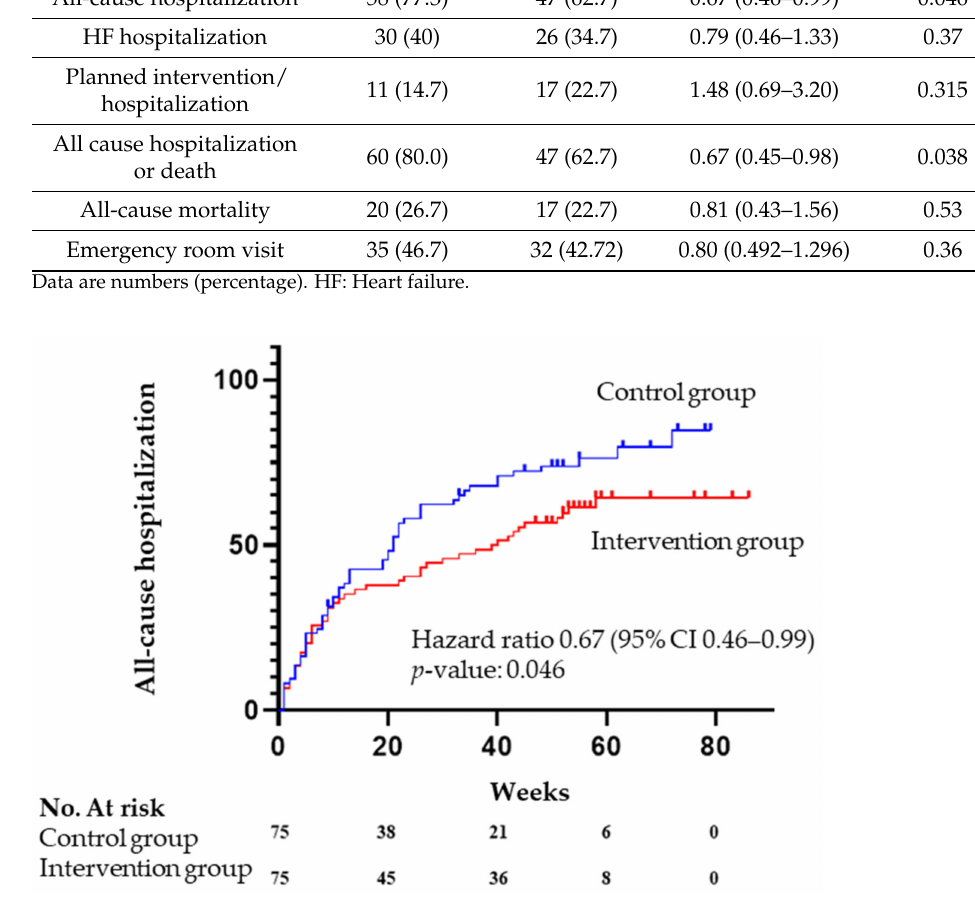
Figure 2. Kaplan–Meier curves for the primary endpoint, according to the study group.